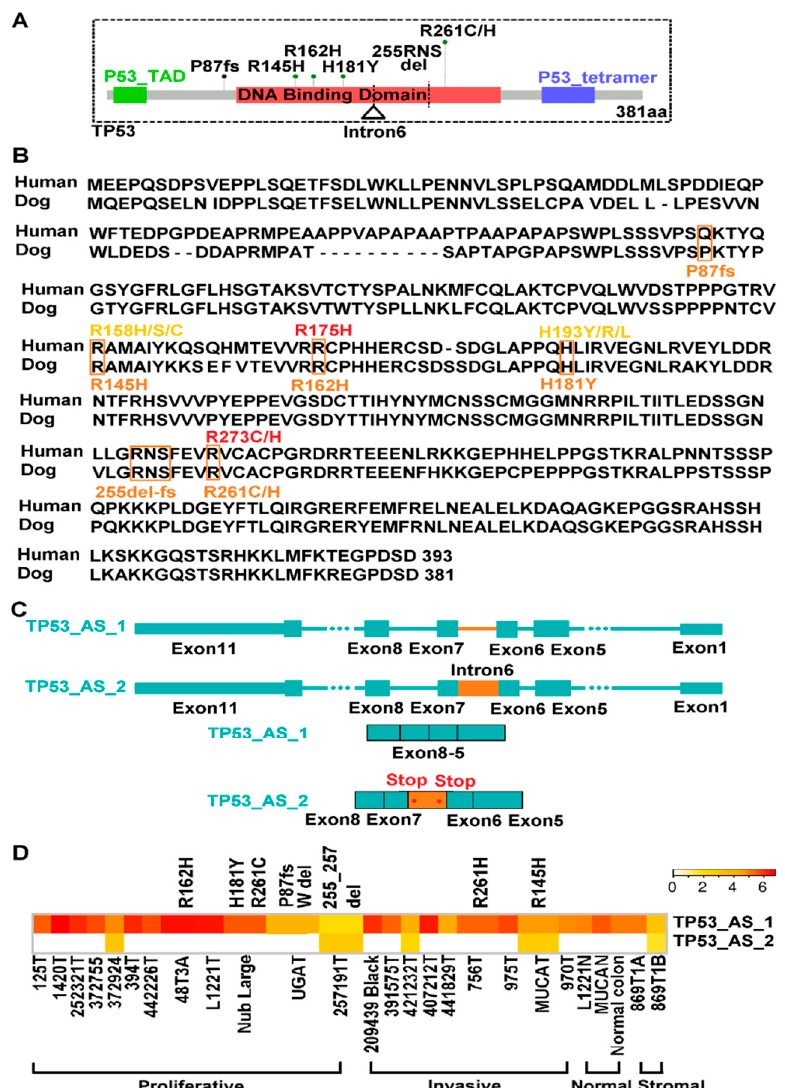
Figure 5. TP53 is recurrently altered in both proliferative and invasive tumors, with some being known drivers. ( A ) TP53 mutations include whole gene deletion, indicated by the dashed lines, and other changes shown. ( B ) Human and dog TP53 protein alignment, with canine mutations and some of their human counterparts (e.g., R175H and R273C/H) indicated below and above the alignment respectively. ( C ) Intron 6 retention, yielding two premature stop codons, was detected. ( D ) TP53 is altered in both proliferative and invasive tumors. The heatmap indicates the abundance of the two transcripts shown in (C). See also Table S5 and Figure S4.